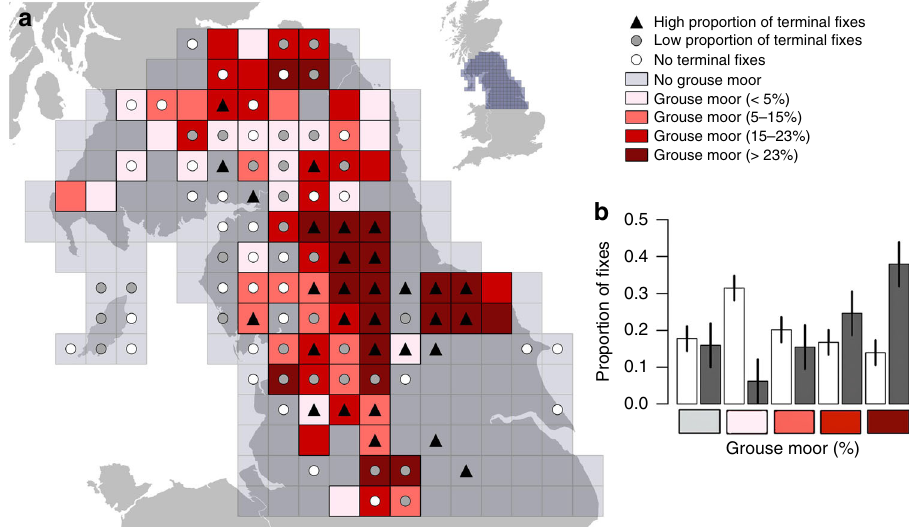
Fig. 3 Hen harrier terminal week fi xes in relation to grouse moors. Data include only satellite-tracked hen harriers that were known to have been illegally killed and those that suddenly disappeared when their tag stopped with no indication of a prior malfunction ( n = 42) and the area (grid squares) encompassed 98% of the tracking data from these individuals and 91% of data from all tracked harriers. a Data in northern England and southern Scotland are displayed on a 20 × 20 km 2 grid. Points (circles and triangles) are displayed for all grid squares with more than fi ve fi xes. White circles show grid squares used by hen harriers with no fi xes from terminal weeks. Grey circles represent grid squares with a below average (median) proportion of terminal week fi xes and black triangles represent above average proportion. Grouse moor distribution is shown (red scale) and calculated as the percentage of 1-km grid squares per 20 km square with heather burning (grouse moor management, Douglas et al. 59 ). b The graph shows the proportion of fi xes (±SE) that fall into each grouse moor group (%) from live weeks (light bars) and terminal weeks (dark bars)